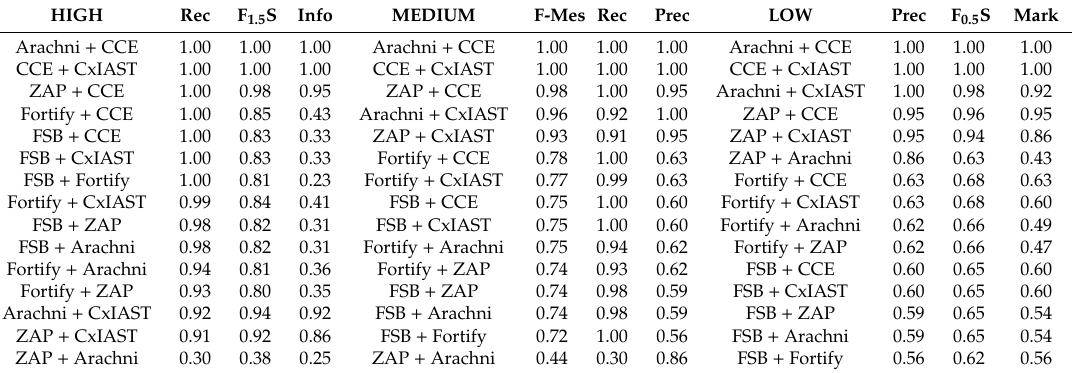
Table 9. Ranking of 2-tools combinations according to distinct level of web application criticality. HIGH